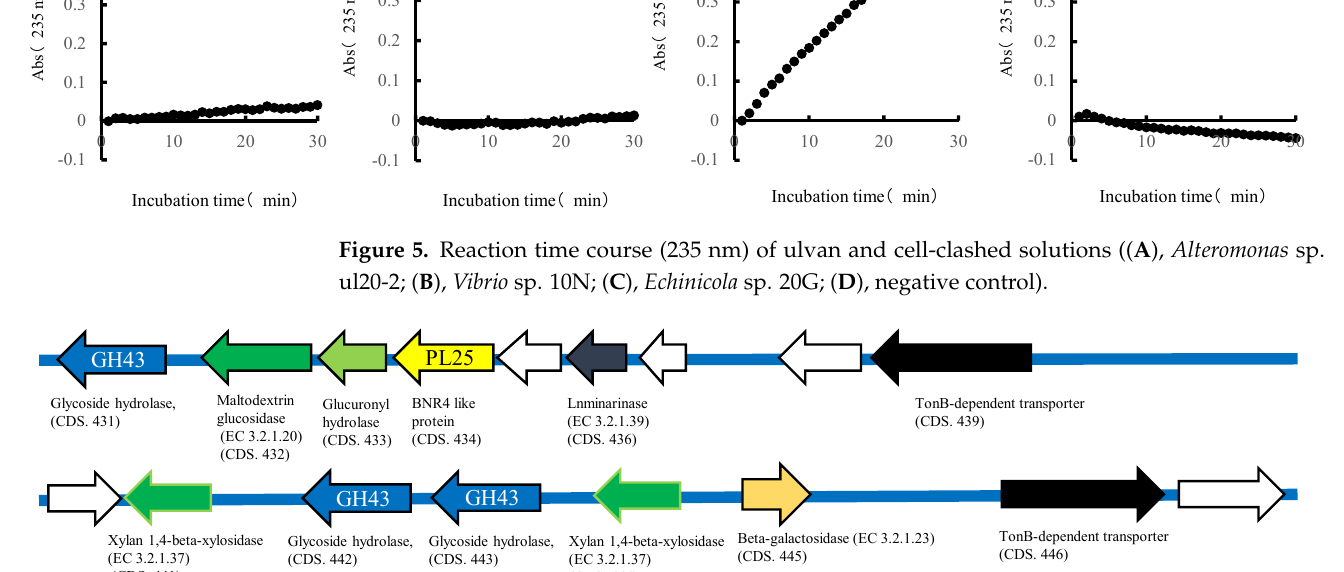
441, 444), β -galactosidase (EC 3.2.1.23) (CDS no. 445), and TonB-dependent transporter (CDS nos. 439, 446) were confirmed. Figure 6. PUL1 of a putative ulvan-degrading-related gene of Echinicola sp. 20G. White arrows indicate hypothetical protein and gray arrows indicate genes that are not relevant to ulvan degradation. PUL2 (shown in Figure 7) contained a rhamnogalacturonan lyase (CDS no. 1735). It